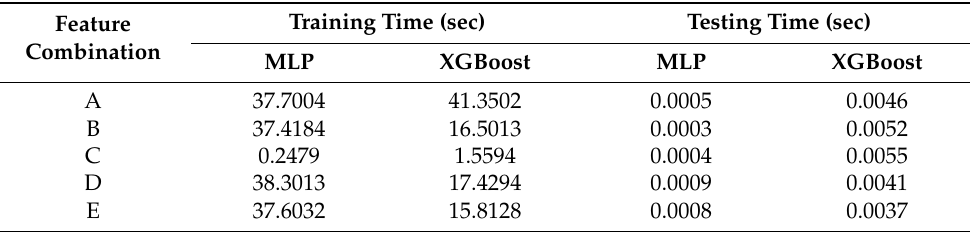
Table 8. Training time and testing time of MLP and XGBoost on the top five classification accuracy feature